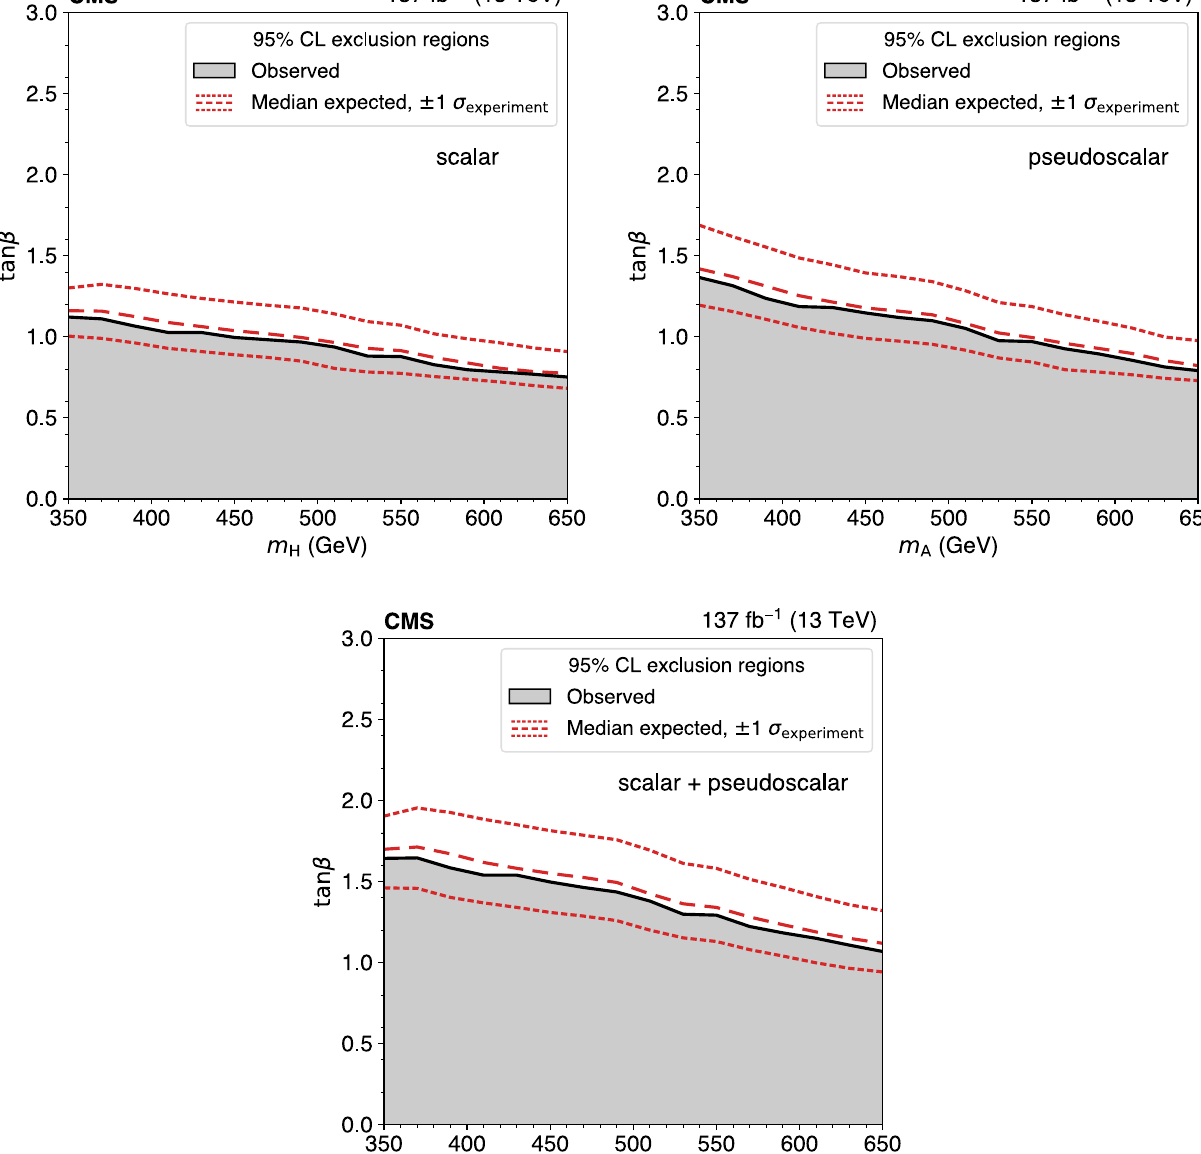
dashed curves around the expected limits indicate the region containing 68% of the distribution of limits expected under the